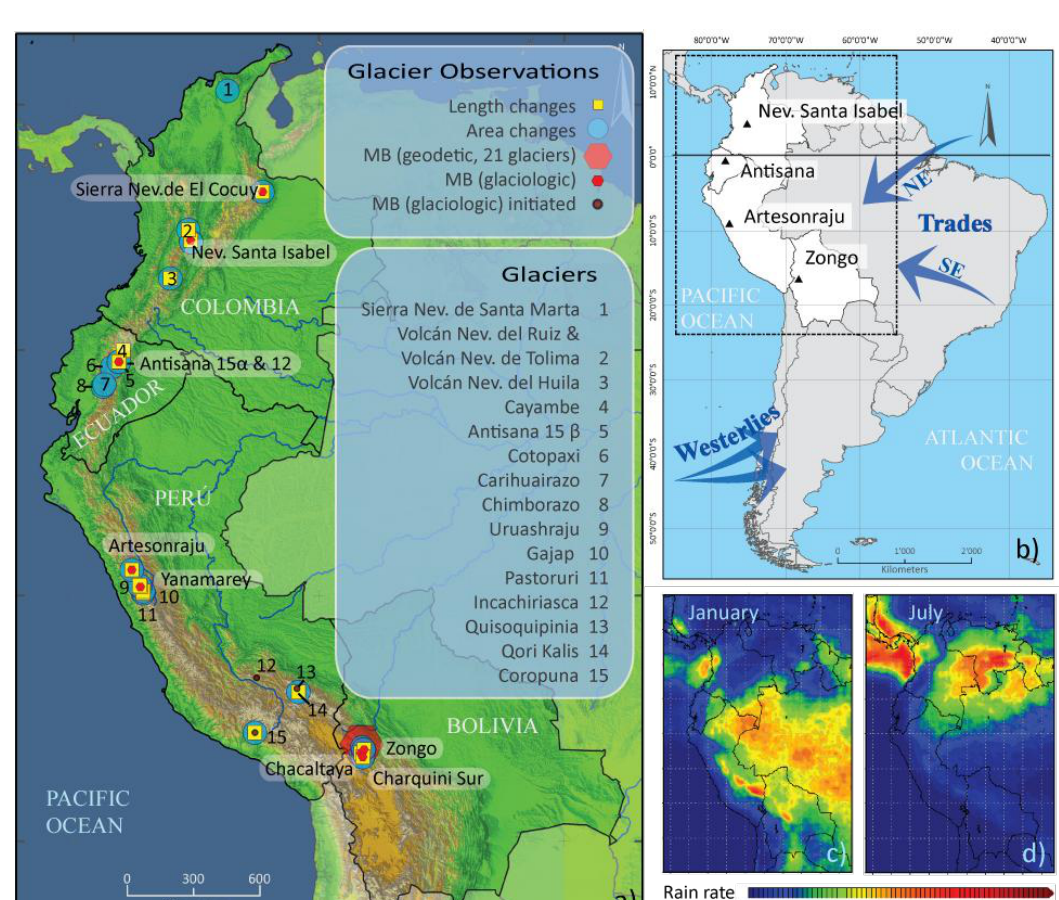
Fig. 1. (a) Glaciers monitored in the tropical Andes. Glaciers with long-term mass balance series (small red hexagons) are labeled (see Table 1 for details). For these glaciers, length (yellow cube) and area (blue circle) records also exist. The large red hexagon depicts a sample of 21 glaciers in the Cordillera Real, Bolivia, for which mass balance reconstructions are available from 1963 to 2006 (Soruco et al., 2009a). Other glaciers whose changes in length and/or in area are monitored are numbered. “MB initiated” indicates glaciers with mass balance measurements starting in 2008 (Incachiriasca), 2009 (Coropuna) and 2010 (Quisoquipinia). (b) General atmospheric circulation over South America. The dotted frame shows the extent of the precipitation maps in (c) and (d) . (c) and (d) Mean hourly precipitation intensity (mmh − 1 ) in January (c) and July (d) , respectively, from 1998 to 2010 based on TRMM (Tropical Rainfall Measurement Mission) Product 3B43